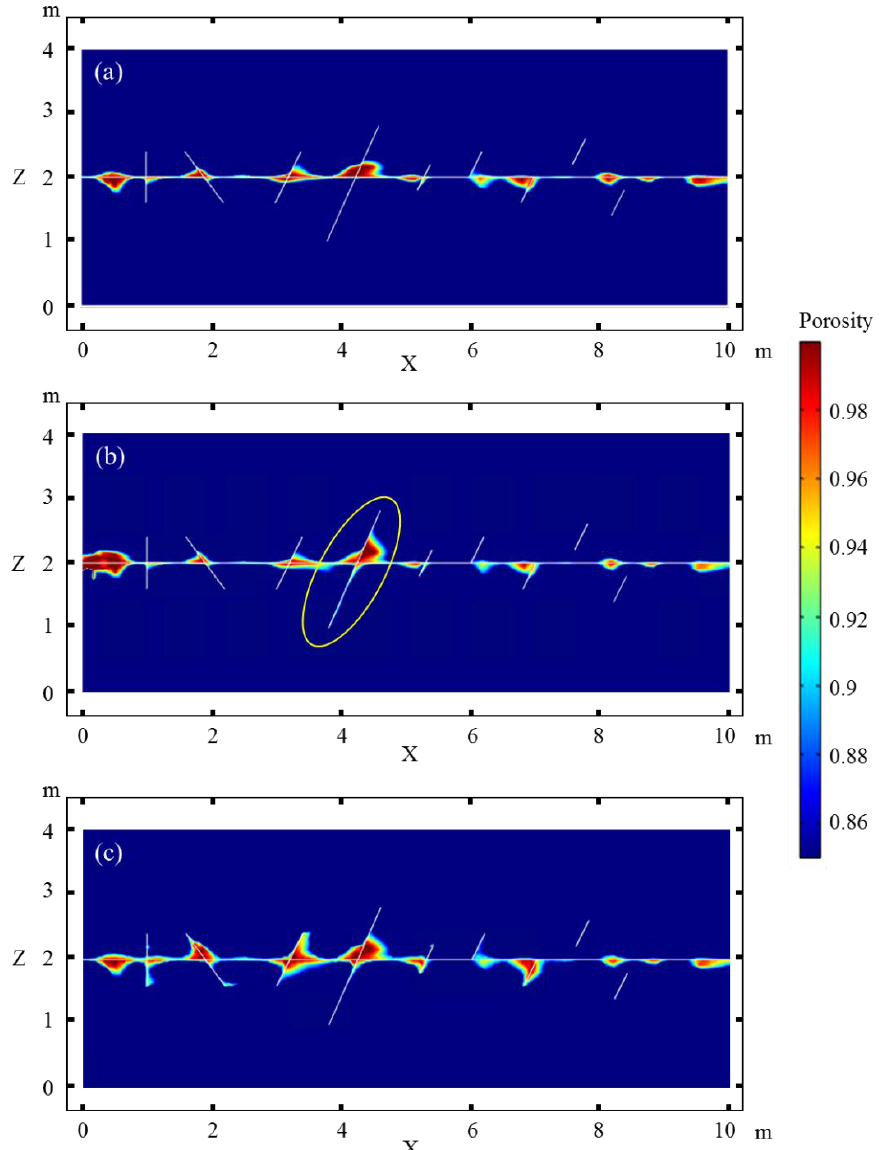
Figure 5. Effects of intersecting fractures on the dissolution along the horizontal fracture. ( a ) Cross fracture set 1: the horizontal fracture aperture was set to 𝑏 1 and the cross fracture aperture was set to 𝑏 2 ; ( b ) cross fracture set 2: the apertures of the horizontal fracture and cross fracture IV were set to 𝑏 1 and all other cross fractures apertures were set to 𝑏 2 ; ( c ) cross fracture set 3: the horizontal fracture aperture was set to 𝑏 1 and the aperture of the cross fractures was set to √5𝑏 2 .